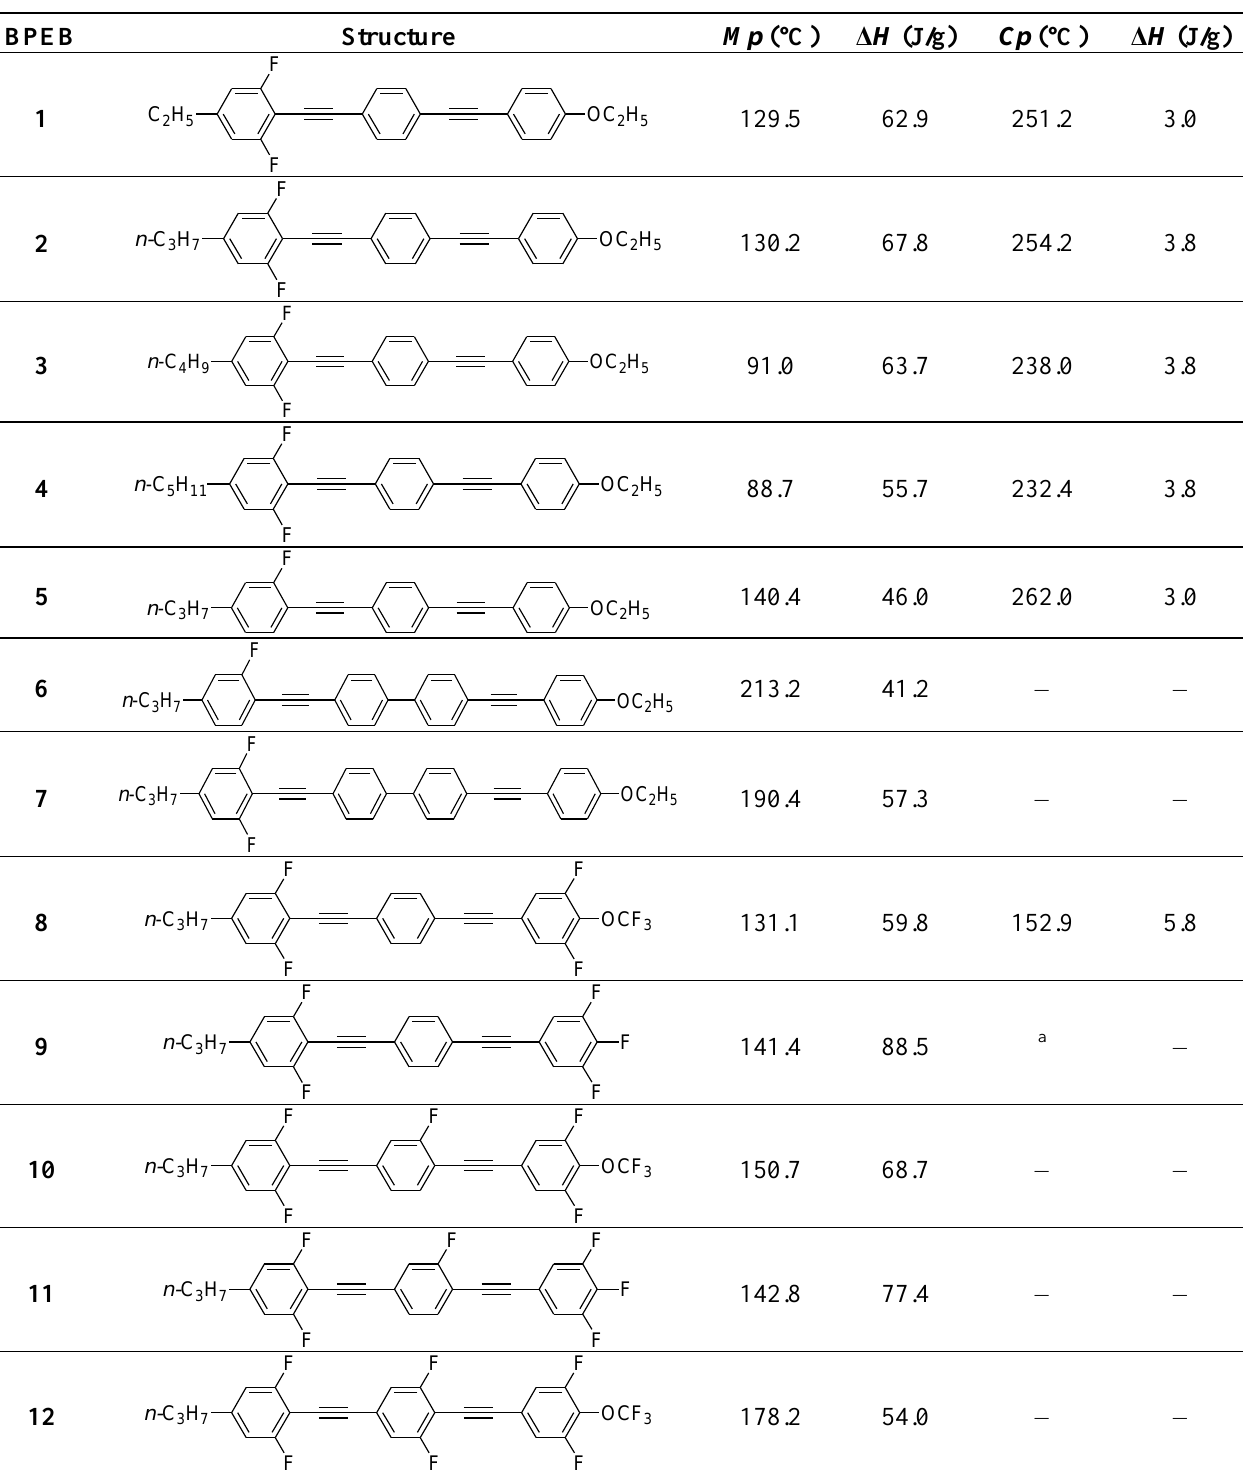
Table 1. Melting points and clearing points of 1,4-bis(phenylethynyl)benzene derivatives (BPEBs) and analogues by